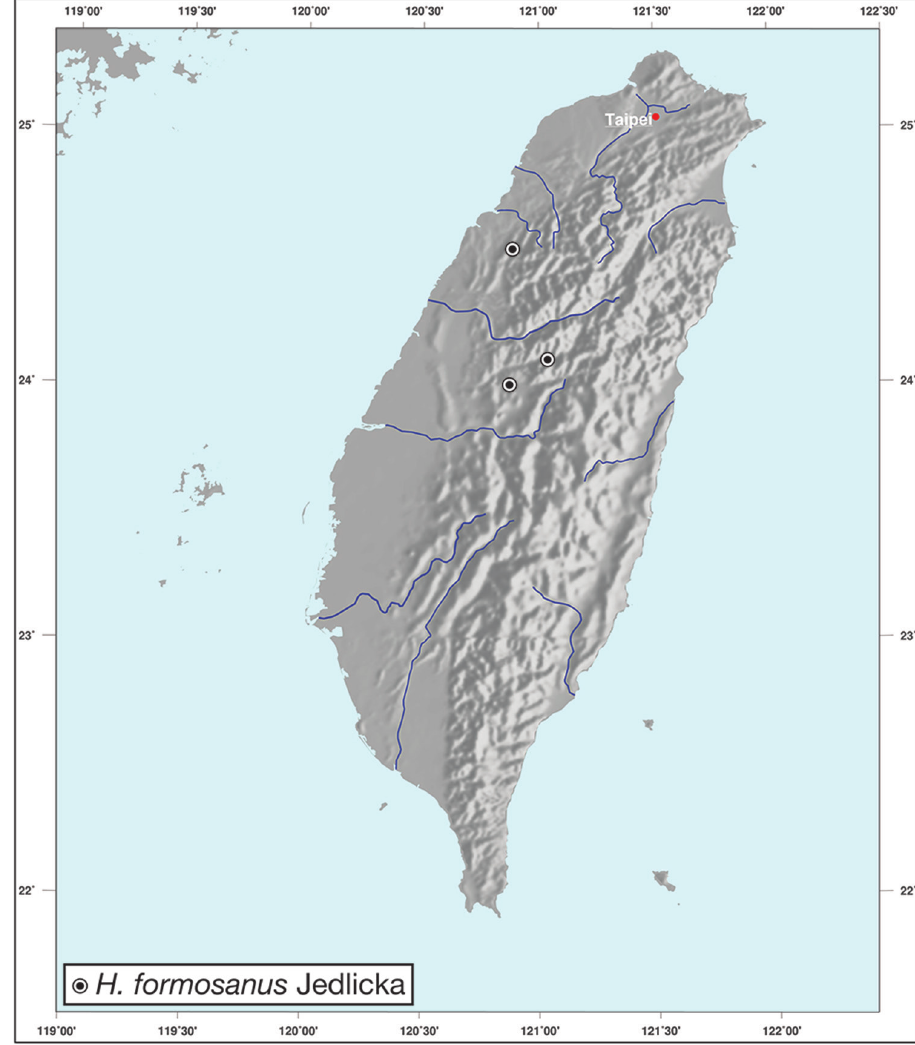
Figure 81. Map showing known localities for species of the genus Holcoderus Chaudoir, in